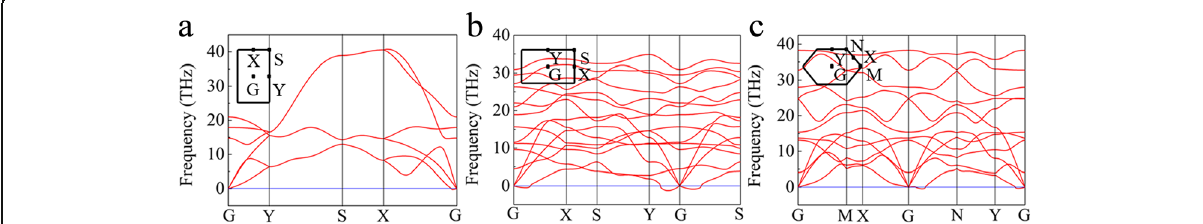
Fig. 2 The phonon dispersion of the a buckled triangular, b β 12 , and c χ 3 boron sheets. The high symmetry points are shown on the left corner